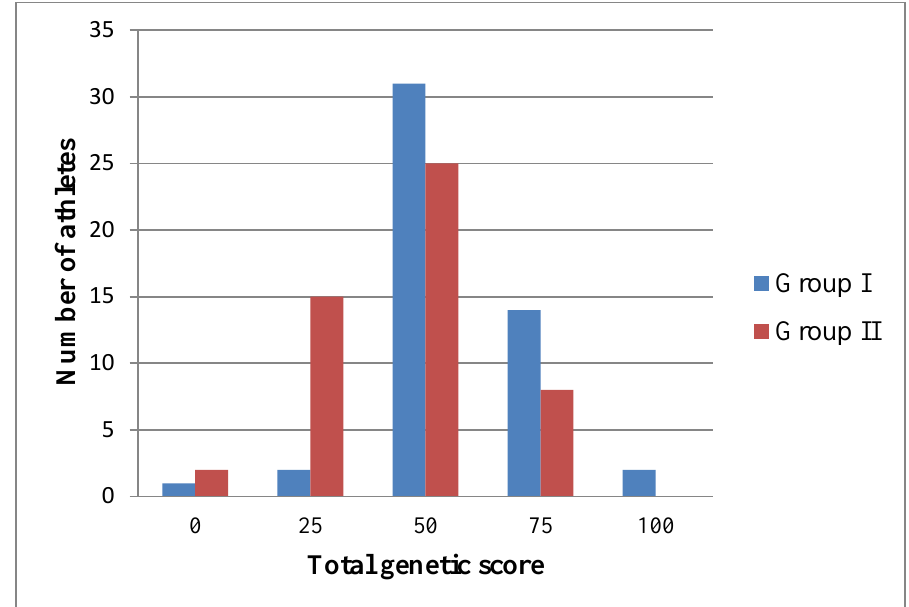
Figure 3. Distribution of the total genetic score established in combatants ( n = 100) for the quality of “ endurance ” , based on the polymorphism of the NOS3 and PPARGC1A genes.